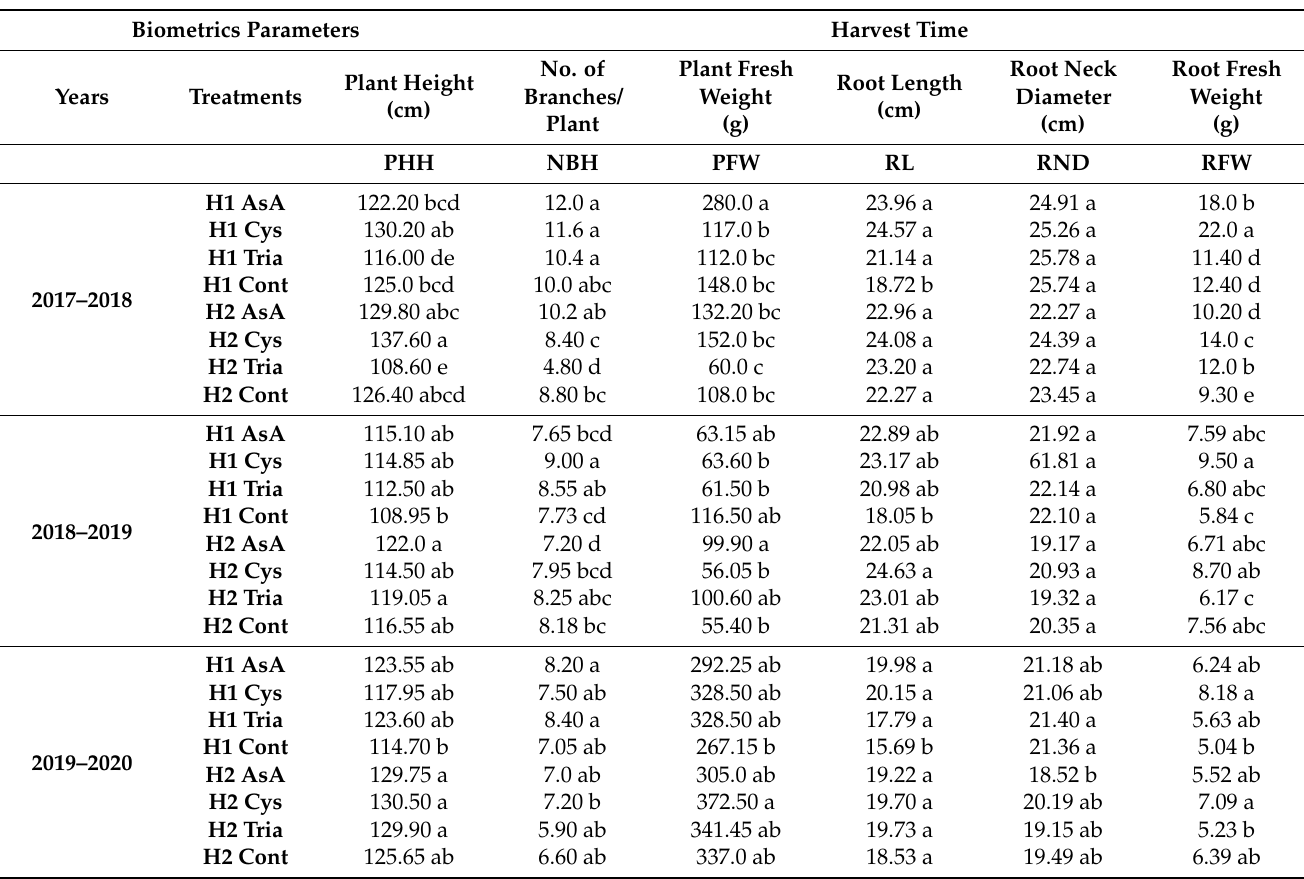
Table 8. Effects of seed priming and foliar treatment with bioactive substances on biometrics parame- ters of canola cultivars at harvest time (between the years 2017–2020).